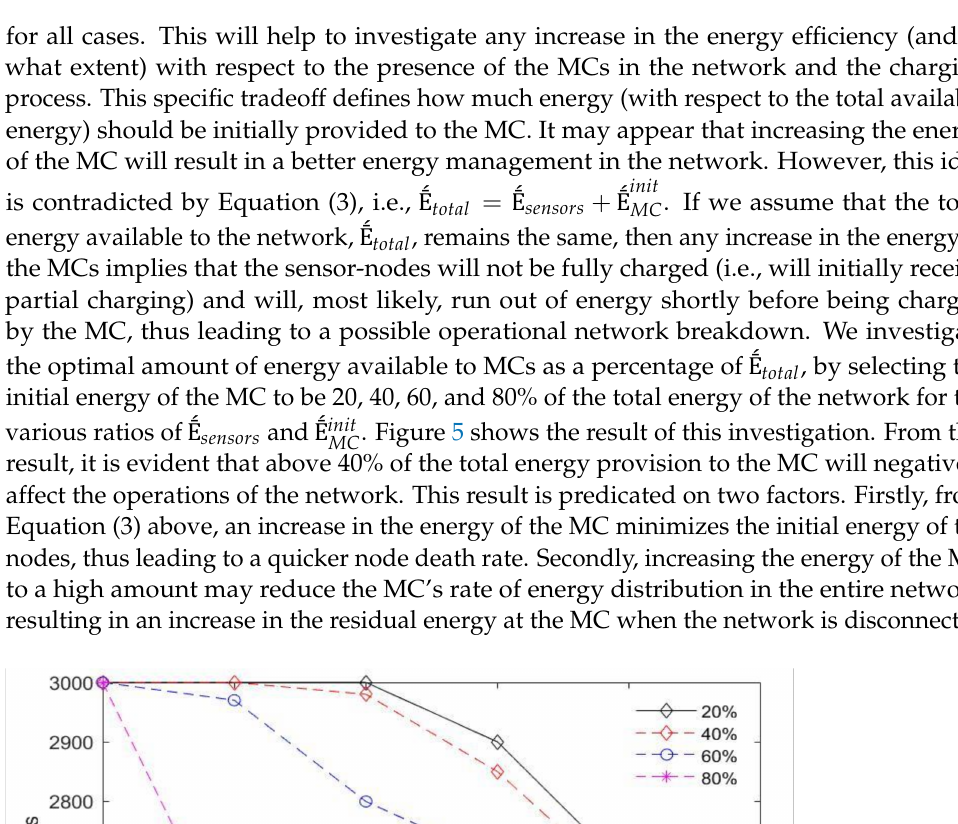
8 of 28 Figure 1. Network model and components . 3.2. The Deployment and Energy Model Three kinds of devices can be identified with the proposed scheme, namely, the static sensors, the mobile chargers (MCs), and the static sink, as shown in Figure 2. Our model assumes that there are 𝓝 sensors of the wireless communication distance ɖ randomly distributed in a circular sensing field with the area ⍲ and the radius ℜ (we investigate both uniform and non-uniform distributions) and n MCs are initially deployed at the center of a circular area along the x-y coordinates in Equation (1): (𝑚, 𝑛) = (cid:3421) ℜ 2 cos (cid:4678)𝜋 n (2𝑝 − 1)(cid:4679) , ℜ 2 sin (cid:4678)𝜋 n (2𝑝 − 1)(cid:4679)(cid:3425) (1) where p = {1, 2, … n}. If we assume that the 𝓝 sensors are uniformly and randomly distributed in a circular area of the radius ℜ , then the network density is given by: